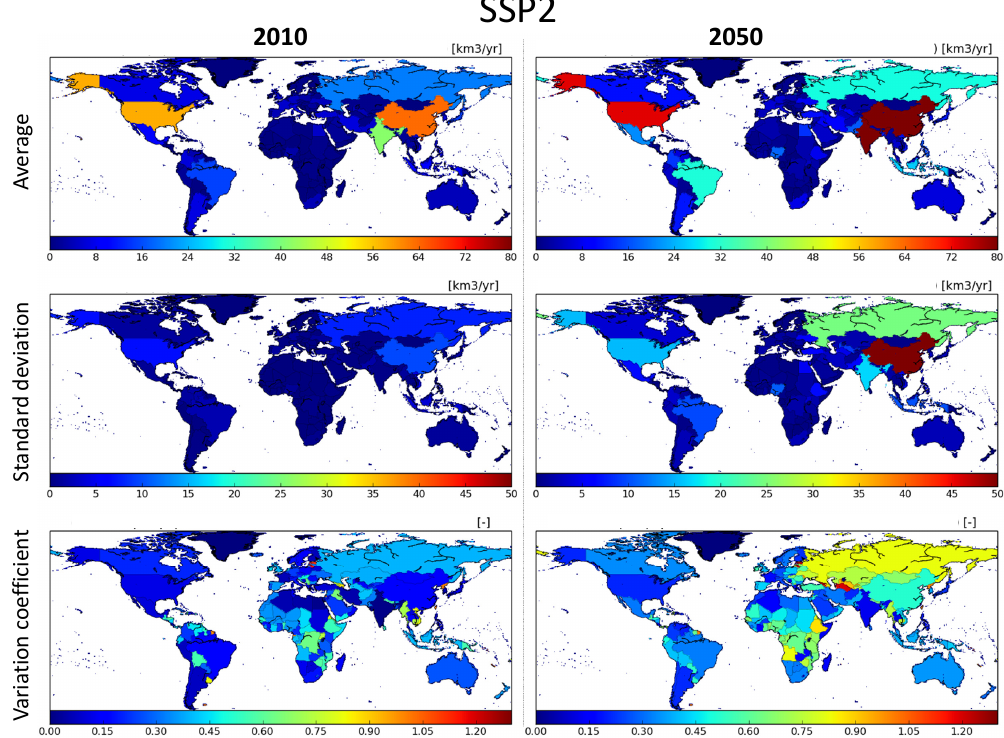
Figure 6. Global maps of projected domestic water withdrawals calculated by the global water models H08, PCR-GLOBWB, and WaterGAP for the years 2010 and 2050, respectively, under the SSP2 scenario. Avr, Std, and Std/Avr denote average, standard deviation, and coefficient of variations